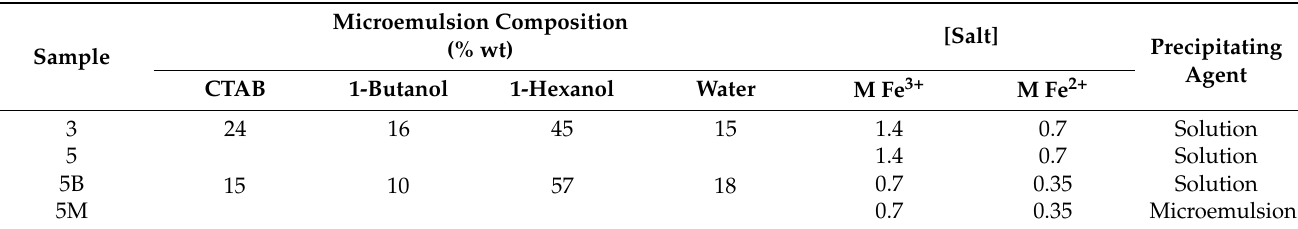
Table 2. Nanoparticles samples synthesized by the ME method with their compositions (% wt). Molar composition of the aqueous phase, and the way of adding the precipitation